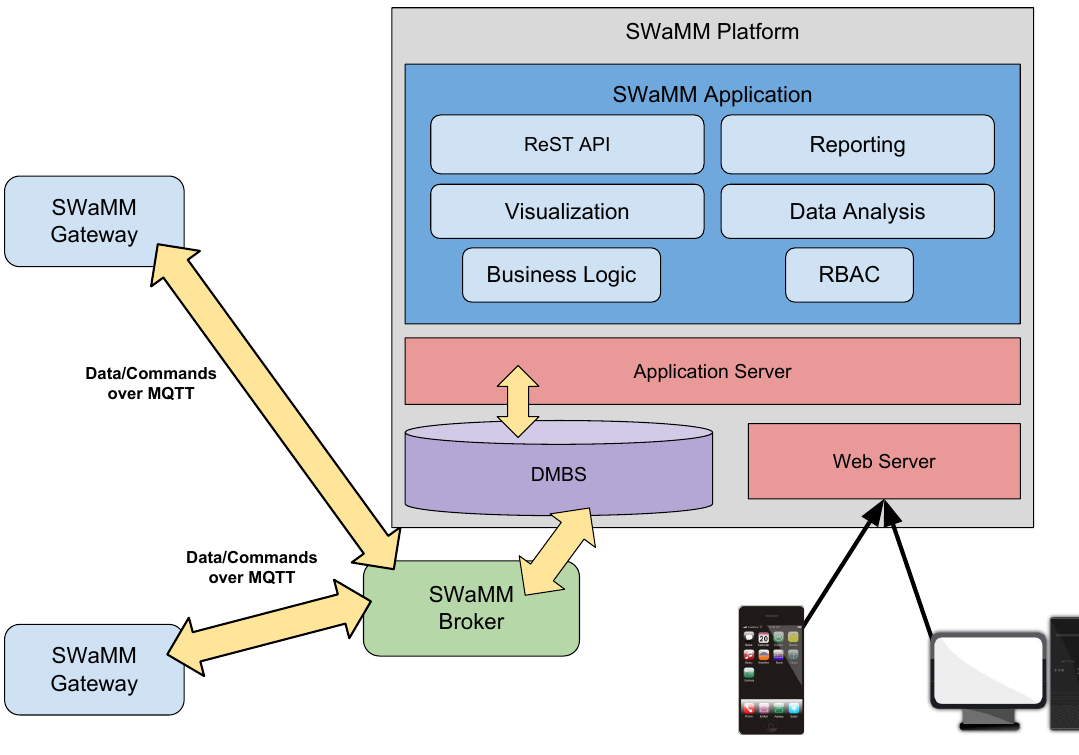
Figure 6. SWaMM Platform